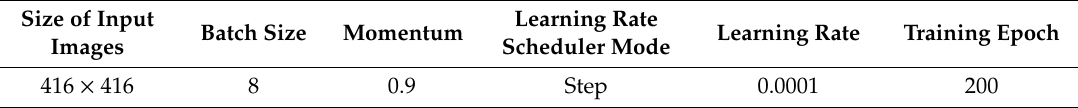
Table 3. Initialization parameters of YOLOV3–Mobilenet network.